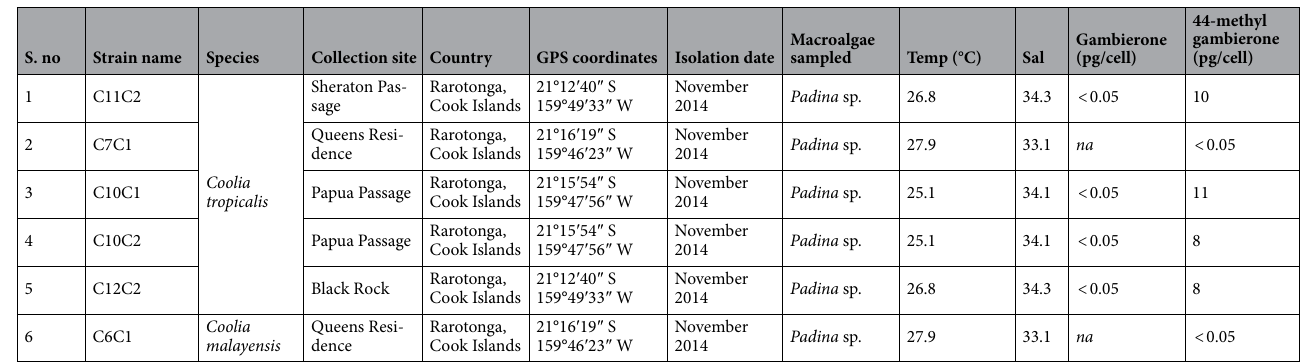
Table 2. Summary of the Coolia strains sampled in this study. na represents no